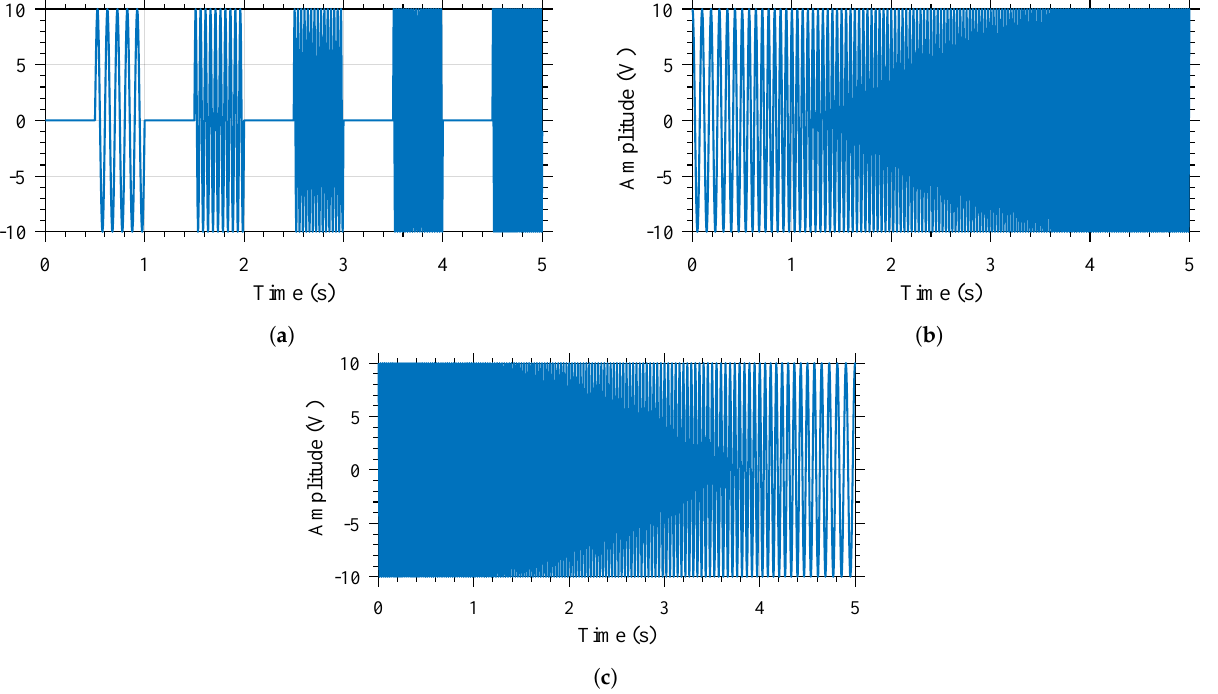
Figure 7. Examples of three of the excitation signal types used: ( a ) PSF , ( b ) CSF , and ( c ) CSB .